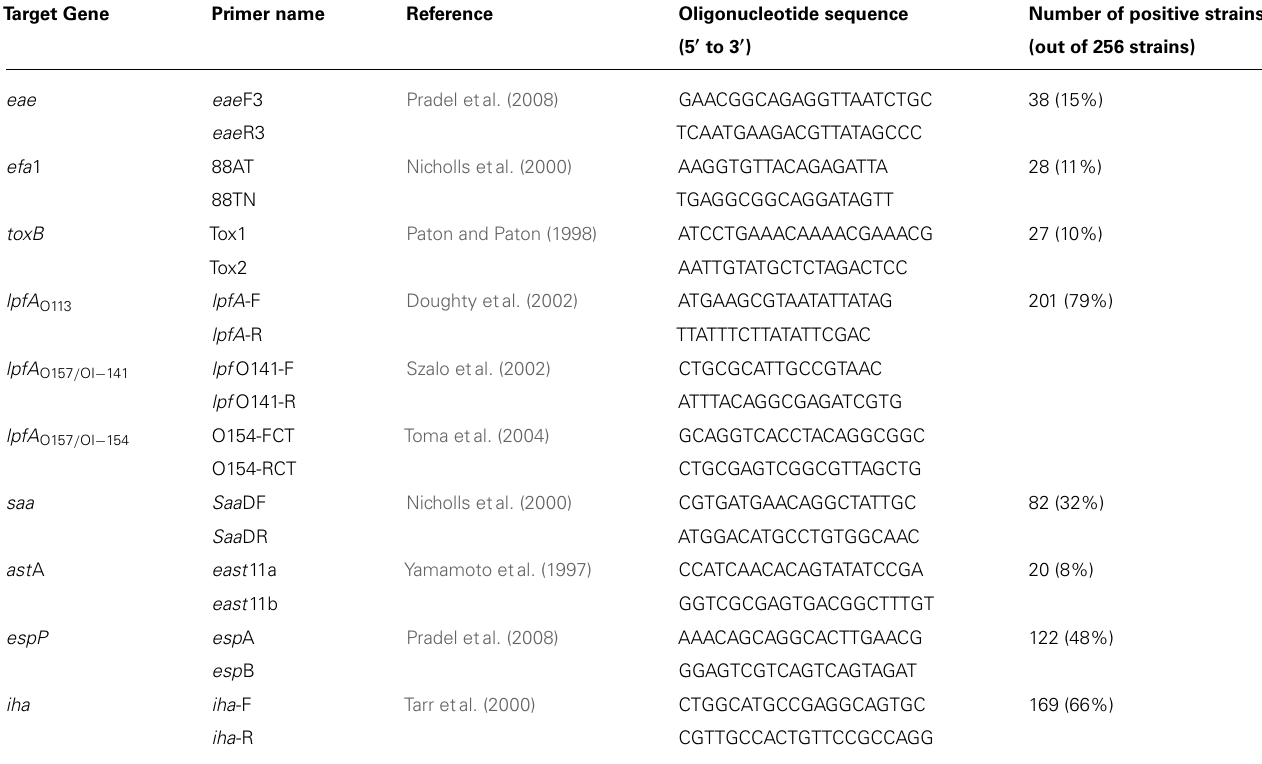
Table 2 | Primers used for genes targeting and proportion of positive